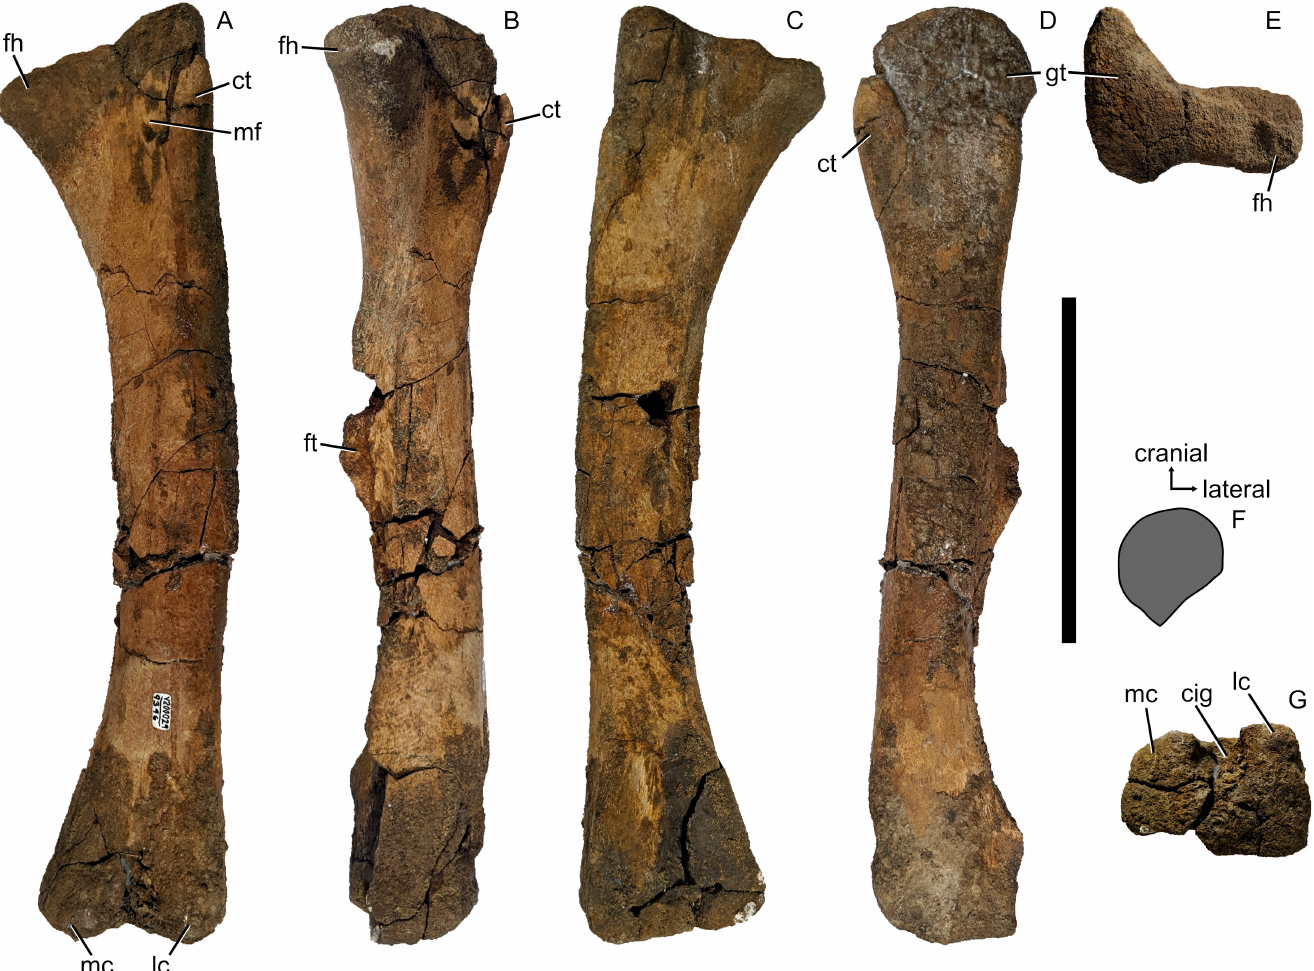
Figure 1. RAM 9396, left femur of cf. Edmontosaurus annectens , photographed in A) anterior; B) medial; C) posterior; D) lateral; E) proximal; F) diaphyseal cross-section with directional arrows, just distal to the fourth trochanter and approximate- ly at the point of measurement 4 in Figure 3B; and G) distal views. Scale bar equals 10 cm. Abbreviations: cig, cranial inter- trochanteric groove; ct, cranial trochanter; fh, femoral head; ft, fourth trochanter; gt, greater trochanter; lc, lateral condyle; mc, medial condyle; mf, muscular